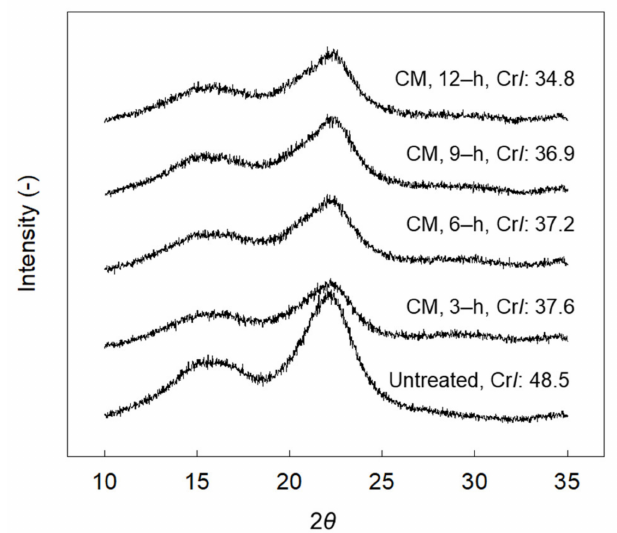
Figure 4. Diffraction patterns and crystallinity indices (Cr I s) of untreated and CM-treated oak